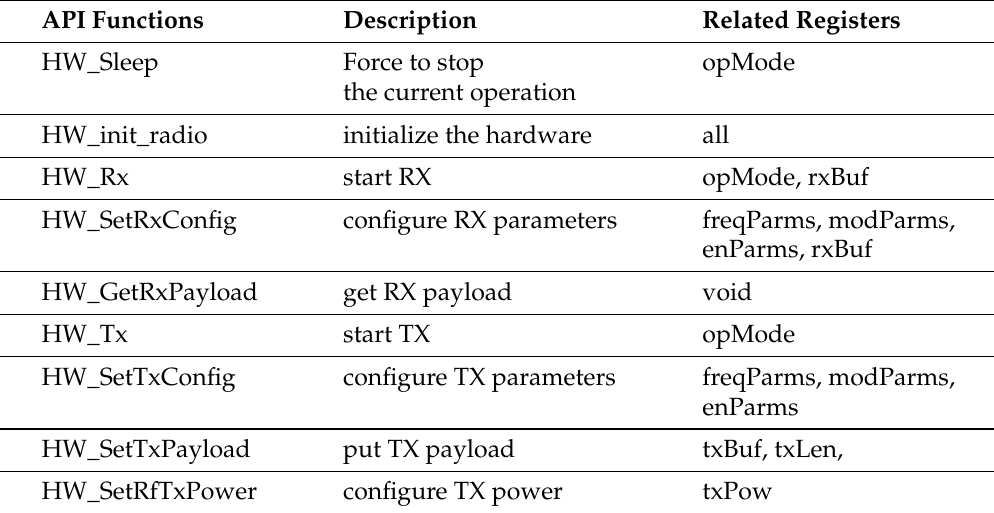
Table 3. The function prototypes of the hardware-interface entity.